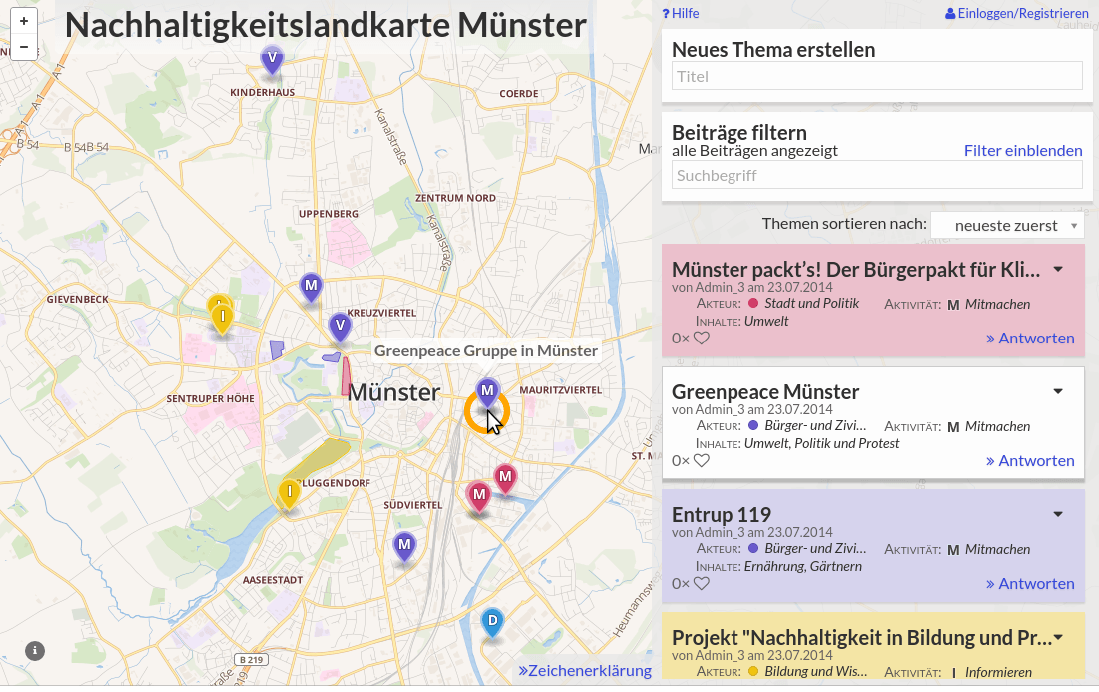
Figure 3 : A “Dialog Map” that displays engagement opportunities for sustainability projects and open issues. An engagement opportunity (Greenpeace Münster) is currently highlighted by a user. Users can drill down into specific topics, search them visually on the map, and use a textual search or filters. Users can also discuss and contribute text as well as locations to each topic, and they can also create new